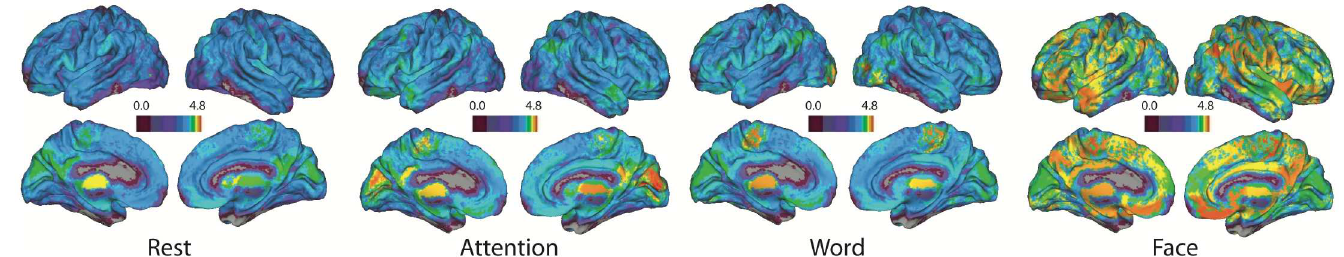
Fig 4. Node degree spatial distribution. Here, the average hyperedge node degree, or number of hyperedges that include each node over all individualsin the multi-task study is plotted on the brain. The scale is logarithmic, and higher values in a region indicate that there are more hyperedges that include the region. There are some regionaldifferences in hyperedgeconcentration, and the face-specific hypergraph shows a global increase in hyperedges across the